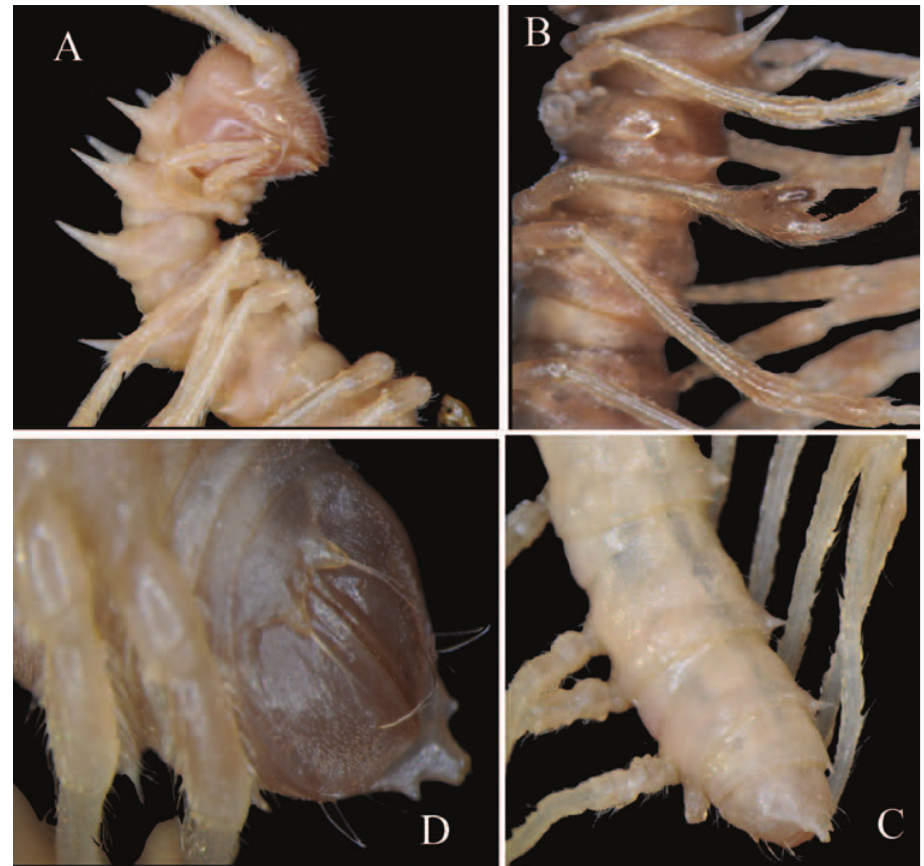
Figure 5. Desmoxytes lui sp. n., ♂ holotype. A anterior part of body, lateral view B body segments 5 to 8, lateral view C posterior part of body, dorsal view D telson, ventral view. Photographed not to